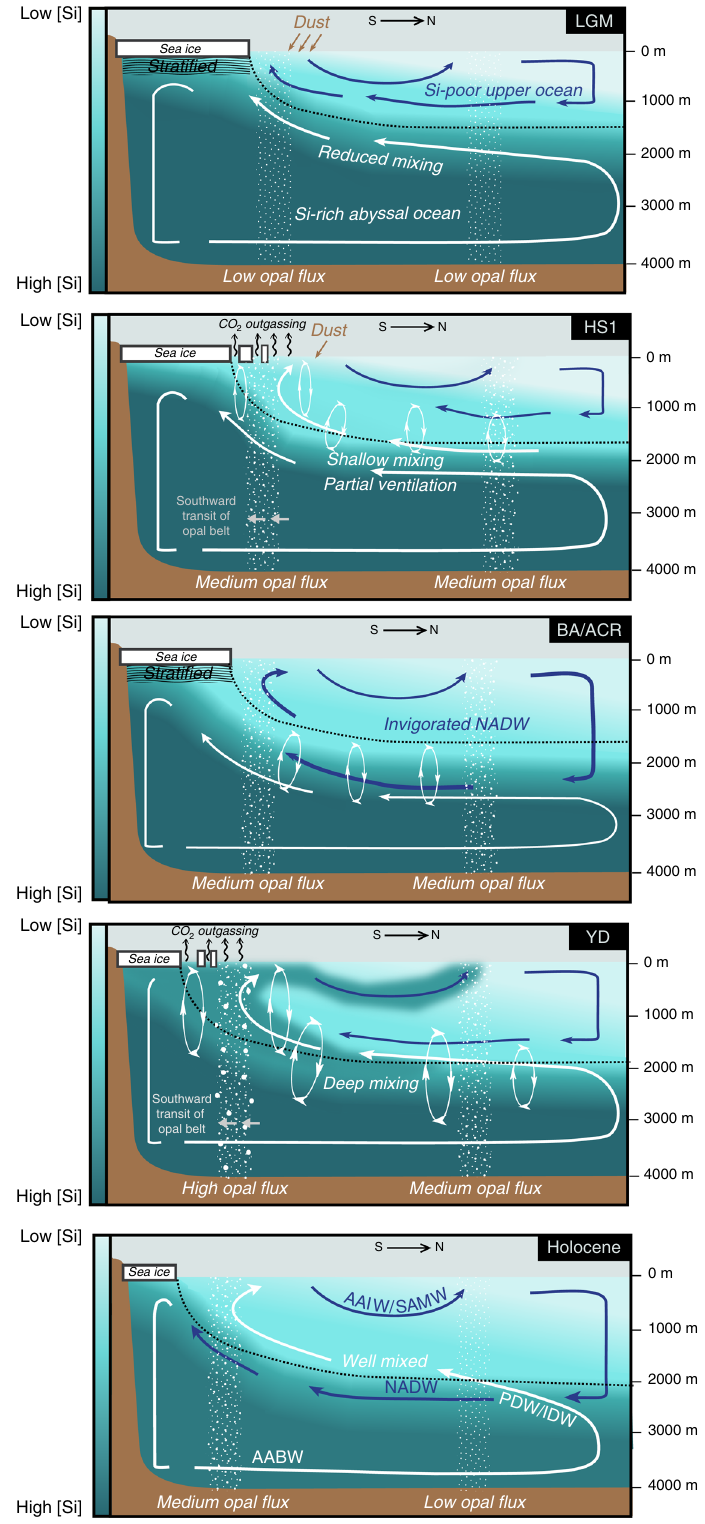
Fig. 5 A schematic representation of the circulation changes and concomitant DSi distribution across the deglaciation. In each panel the upper (NADW/AAIW/SAMW) and lower (AABW/PDW/IDW) circulatory cells are depicted as blue and white arrows, respectively. The shading in each panel represents the concentration of DSi, with the LGM abyssal ocean being more DSi-rich than the modern as a result of reduced mixing. The dotted black line in each of the panels represents the isopycnal at divergence of the upper and lower circulatory cells 54 , the vertical position of which has been suggested to be governed by sea ice extent. Importantly, this schematic demonstrates that only when sea ice is suf fi ciently removed during the Younger Dryas are the deep Si-rich waters tapped into and redistributed into the upper circulatory cell. Southern Ocean and low latitude opal fl uxes are globally generalised based on available data 39,50,81